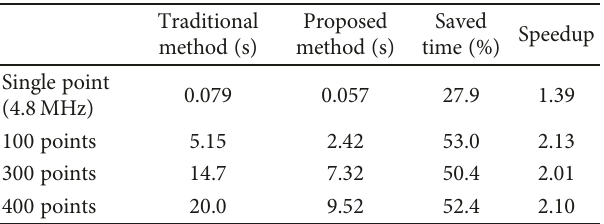
Figure 6: The relative error of the S -parameters between the results of the proposed method and the traditional method. Table 4: CPU time of the traditional method and the proposed method.